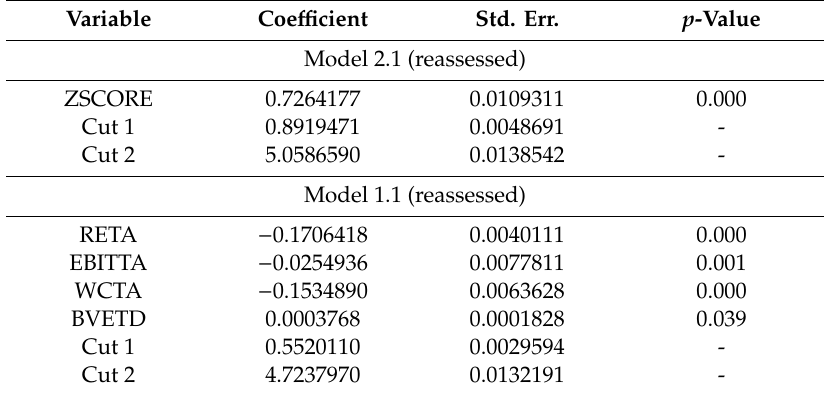
Table 5. Two ordered logistic regression models with either bankruptcy risk or financial ratios as independent variables (dependent variable